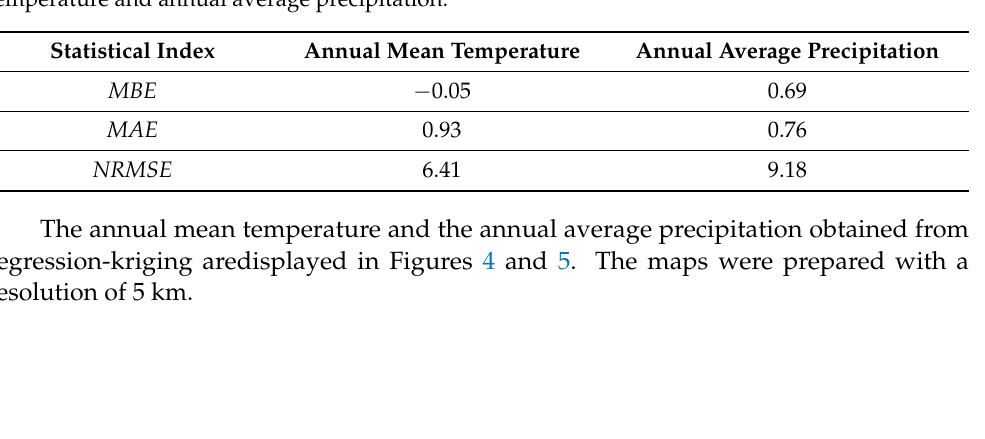
Table 4. Statistical indicators for validation of the interpolation methods for the annual mean temperature and annual average